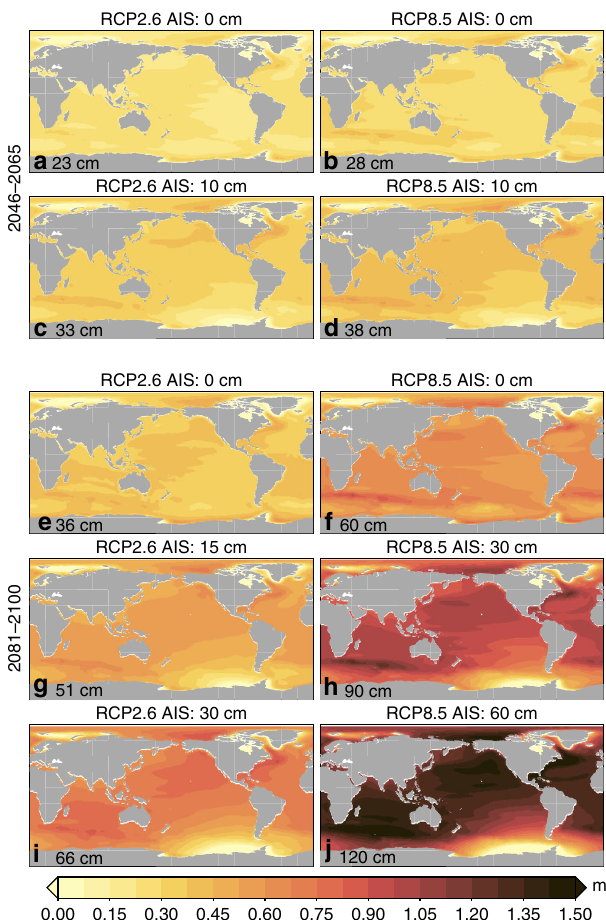
Fig. 1 Mean sea-level change scenarios. Selection of median regional IPCC AR5 MSL scenarios relative to the 1986 – 2005 baseline combined with various AIS contributions. The title of each panel shows the RCP scenario and the AIS contribution in cm. a – d 2046 – 2064. e – j 2081 – 2100 for varying RCP scenarios and AIS contributions. The number in the bottom left corner shows the corresponding global-mean sea-level change. See Supplementary Figs. 1 – 3 for all considered emission scenarios and accompanying uncertainty